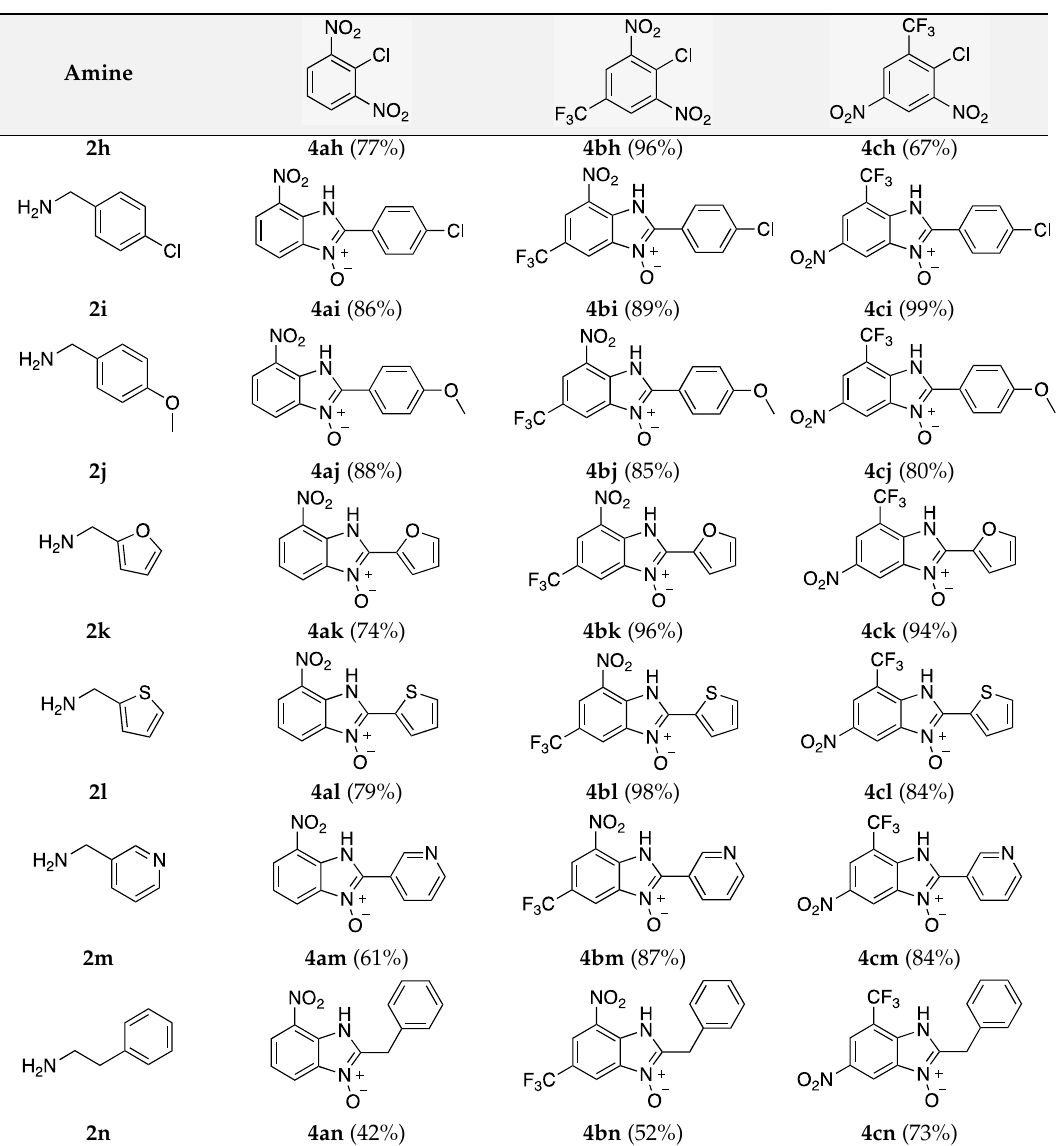
Amine Amine Amine